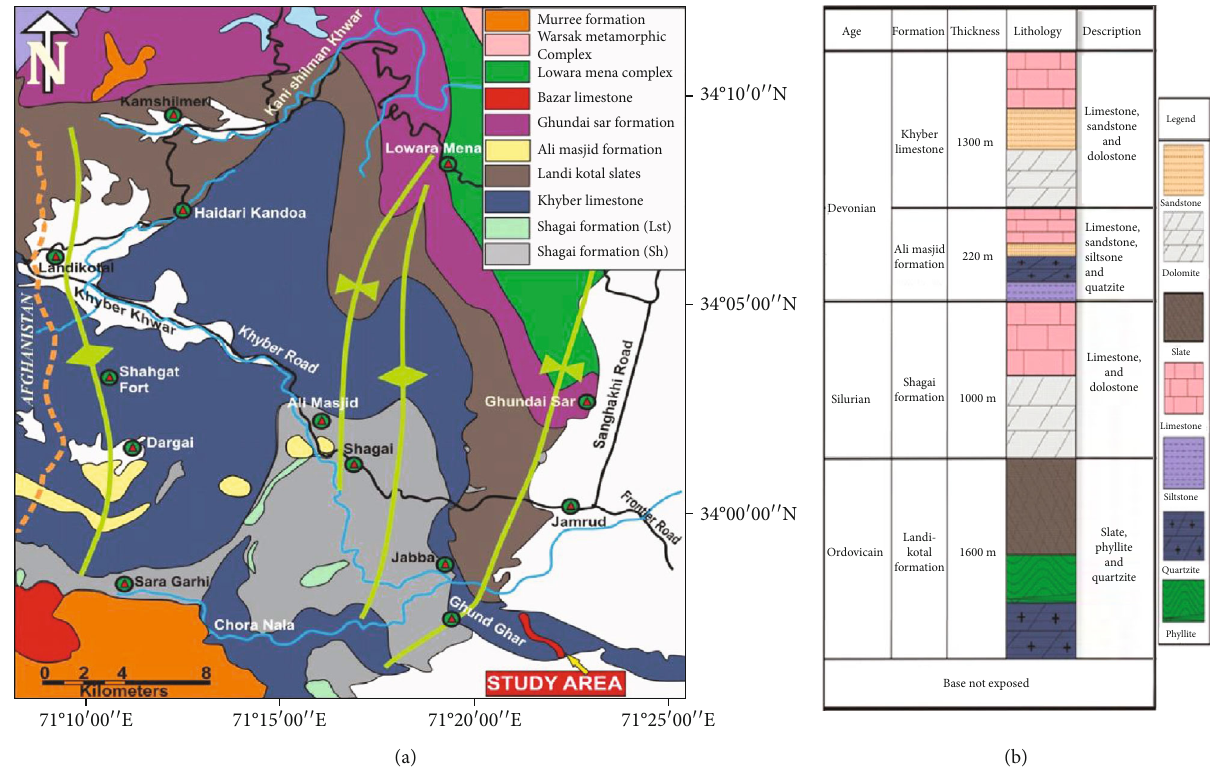
Figure 2: (a) Geological map of the area NW of Peshawar, showing the location of the studied section where igneous intrusions crosscut the Khyber Limestone. (b) Stratigraphic column showing lithological successions of formations exposed in the study area (modi fi ed from Khan et al.